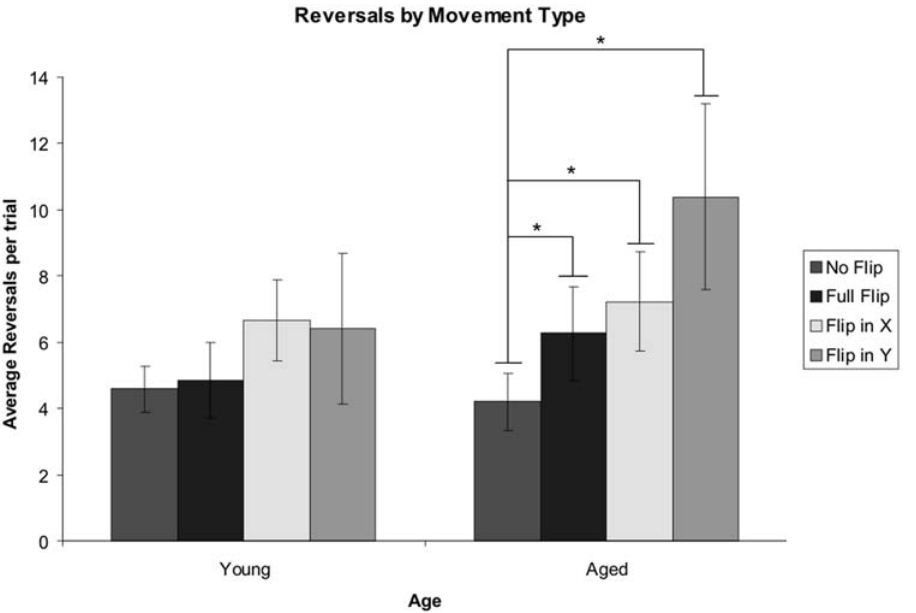
Figure 4. Number of Reversals. During an X- or Y-axis flip, the aged participants had significantly more reversals per trial than on trials when no visuomotor transformation was required. Error bars represent the standard error of the mean. *p , 0.05 indicates a significant